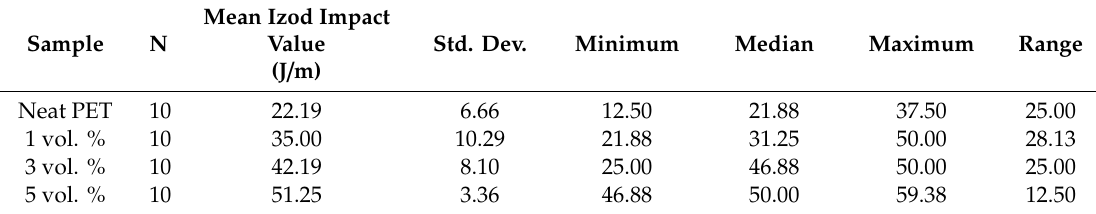
Table 10. Notched Izod Impact resistance in J/m, of amorphous PET and Al 2/Amorphous PET composites. Std. Dev. is the standard deviation. N is the number of tests.